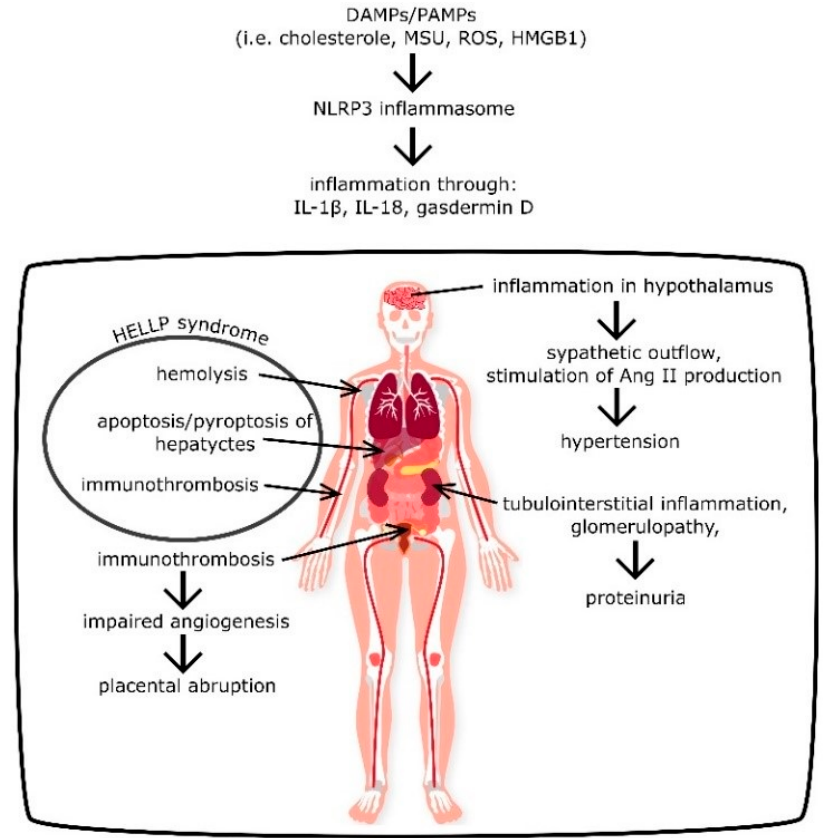
Figure 4. Pathomechanism of pregnancy-induced hypertension (PIH) and preeclampsia (PE) development by the NLRP3 inflammasome. DAMPs—damage associated molecular patterns, PAMPs—patogen associated molecular patterns, MSU—monosodium urate, ROS—reactive oxygen species, HMGB1—high-mobility group box 1 protein.